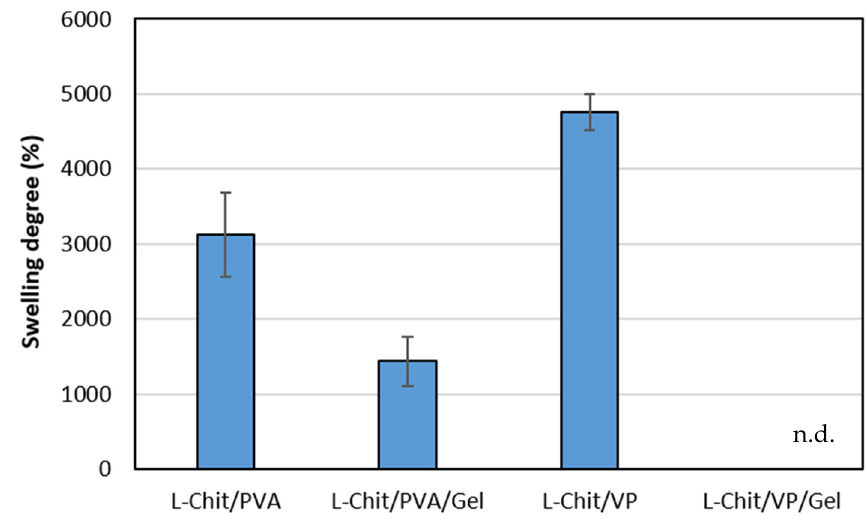
Figure 5. Swelling degree in distilled water of low-Mw chitosan-based membranes γ -irradiated at 10 kGy expressed as mean ± SD ( n = 3); n.d.: not determined.